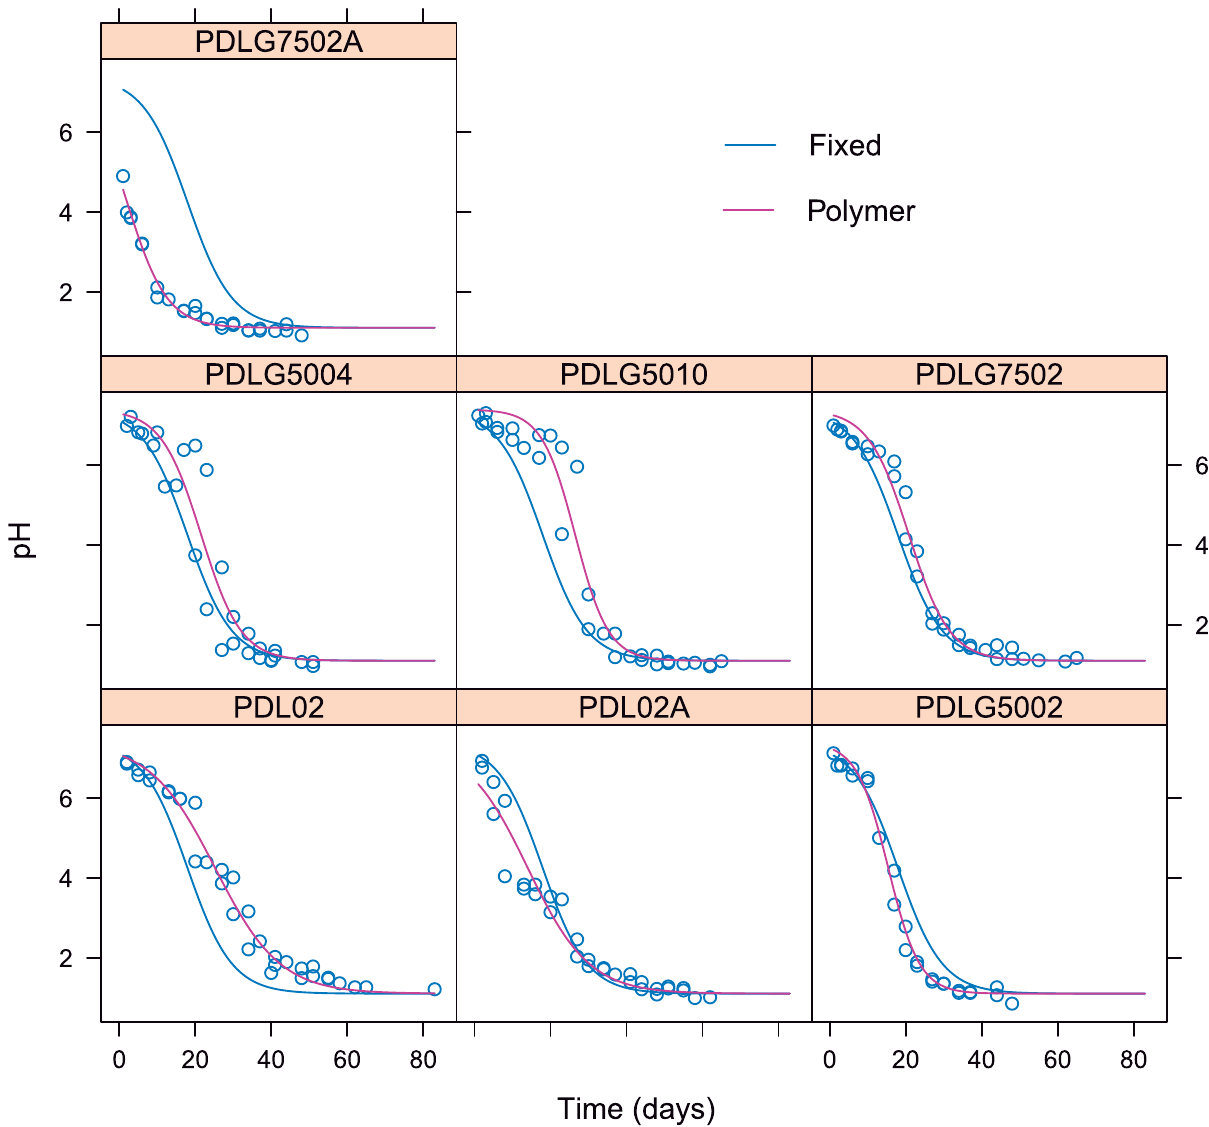
Fig 13. Each panel shows the PDLGA pH versus time for each PDLGA polymer. The nonlinear mixed-effects fitting for each PDLGA polymer is shown and compared with respect to fittings corresponding to the population (obtained using the fixed effects of model parameters).